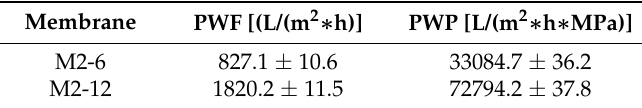
Table 9. PWF and PWP values for membranes M2-6 and M2-12.